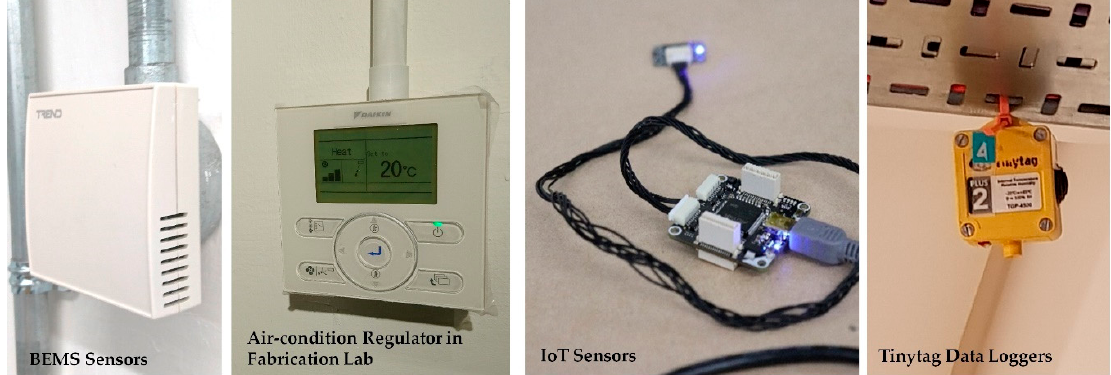
Figure 3. Images of existing Building Energy Management (BEMS) sensors, air-condition regulators, Tinkerforge Bricklets with Internet of Things (IoT) and Tinytag sensor.